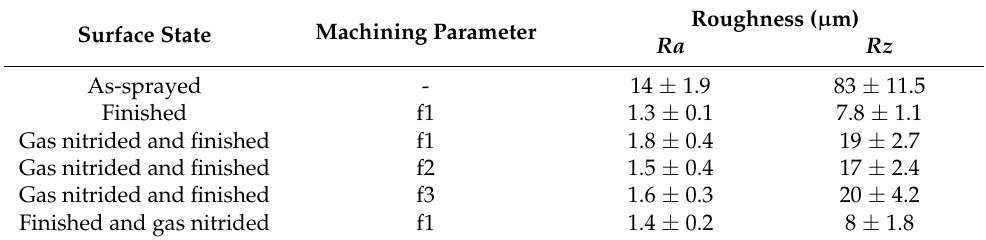
Figure 5. Abbott curves of the finished surfaces before and after gas nitriding. Table 4. Surface roughness of the arc sprayed 17Cr-steel coatings before and after different post- treatments.